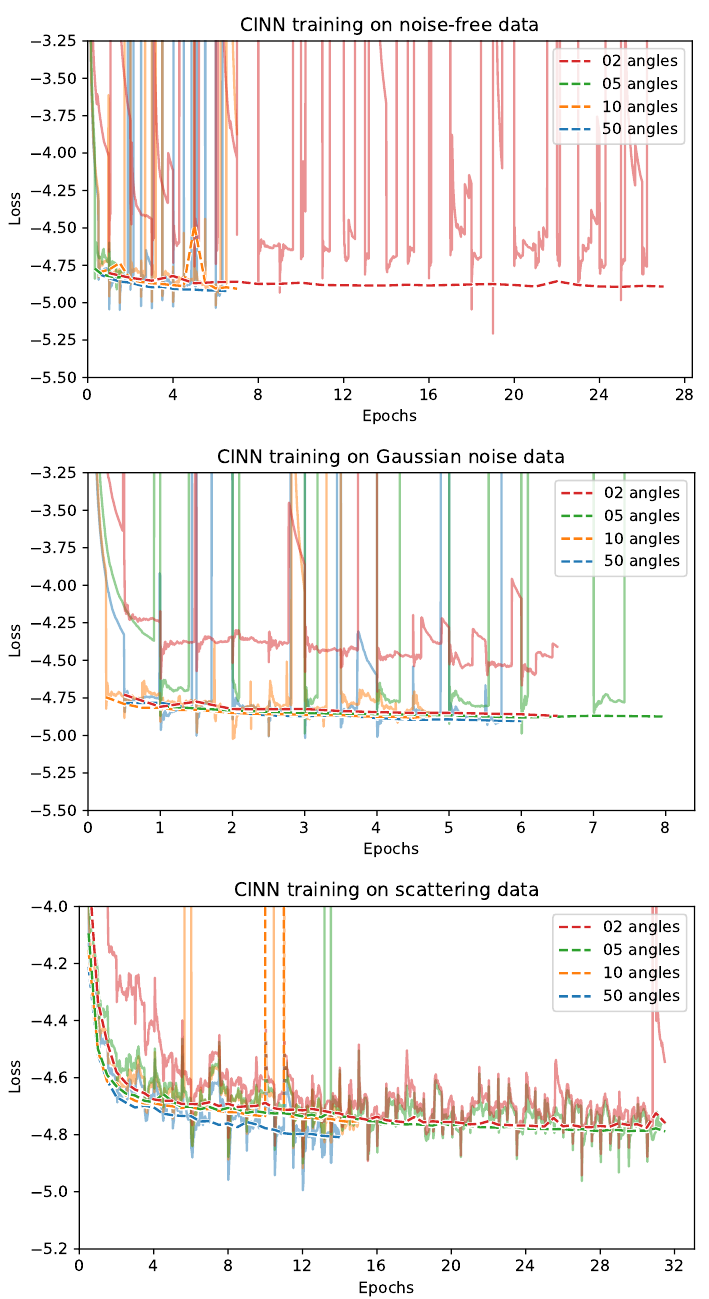
Figure A14. Training curves of CINN on the Apple CT dataset. Dashed lines: average validation loss computed after every full training epoch; solid lines: running average of training loss (at every 50-th step) since start of epoch. For some of the trainings, the epochs were divided into multiple shorter ones. Duration of 20 epochs on full dataset: ≈ 2.5 days (using 2